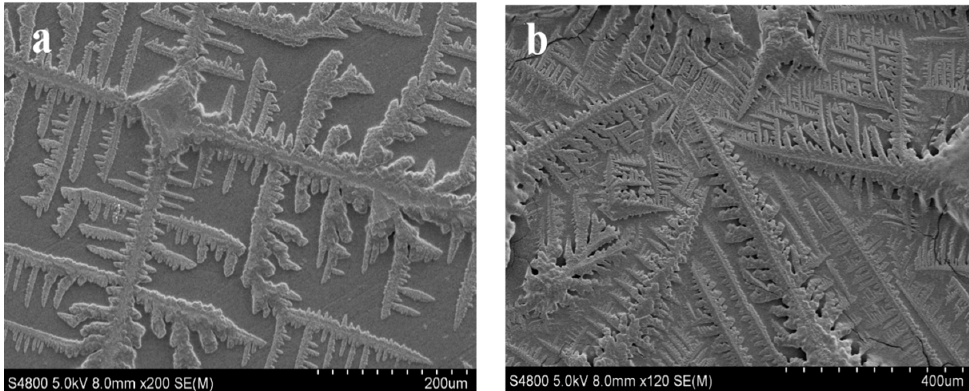
Figure 5. Scanning electron microscopic (SEM) images of PASD in salinity solution: ( a ) sample solution at 200 μ m, ( b ) sample solution at 400 μ m.